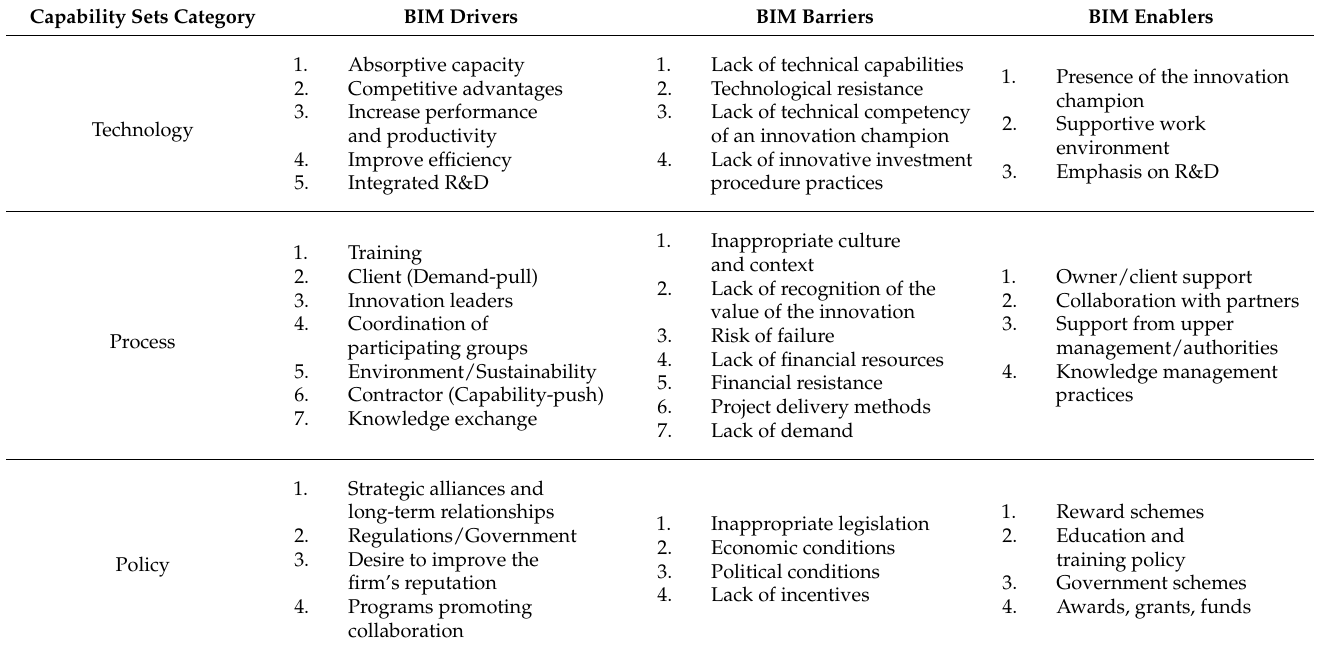
Table 11. BIM drivers, barriers, and enablers in developing